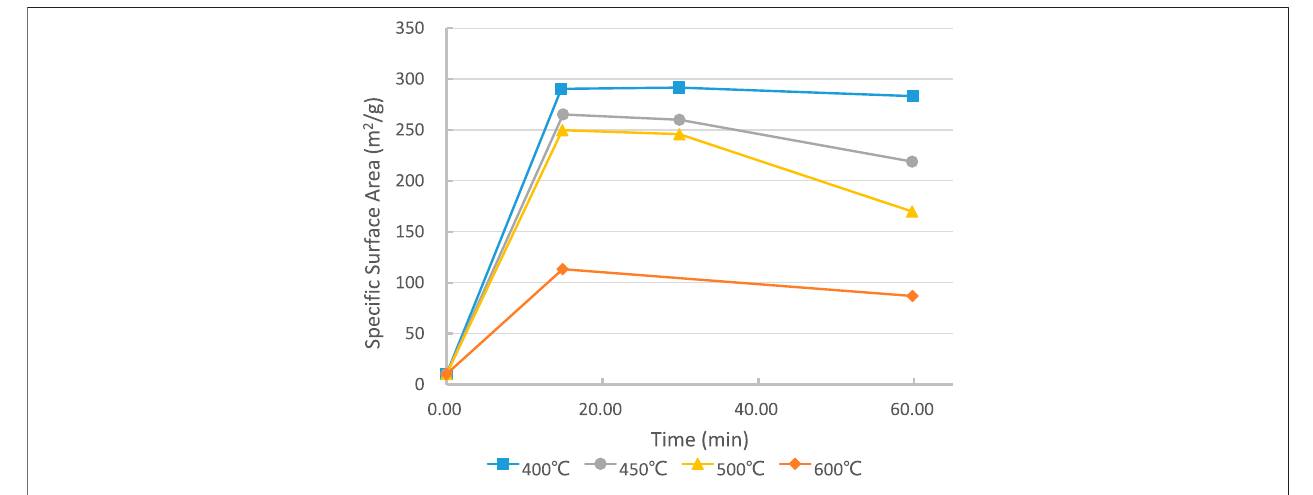
FIGURE 7 | Thermal decomposition vs SSA of magnesia (precipitated magnesium hydroxide). After (Shand, 2006a).